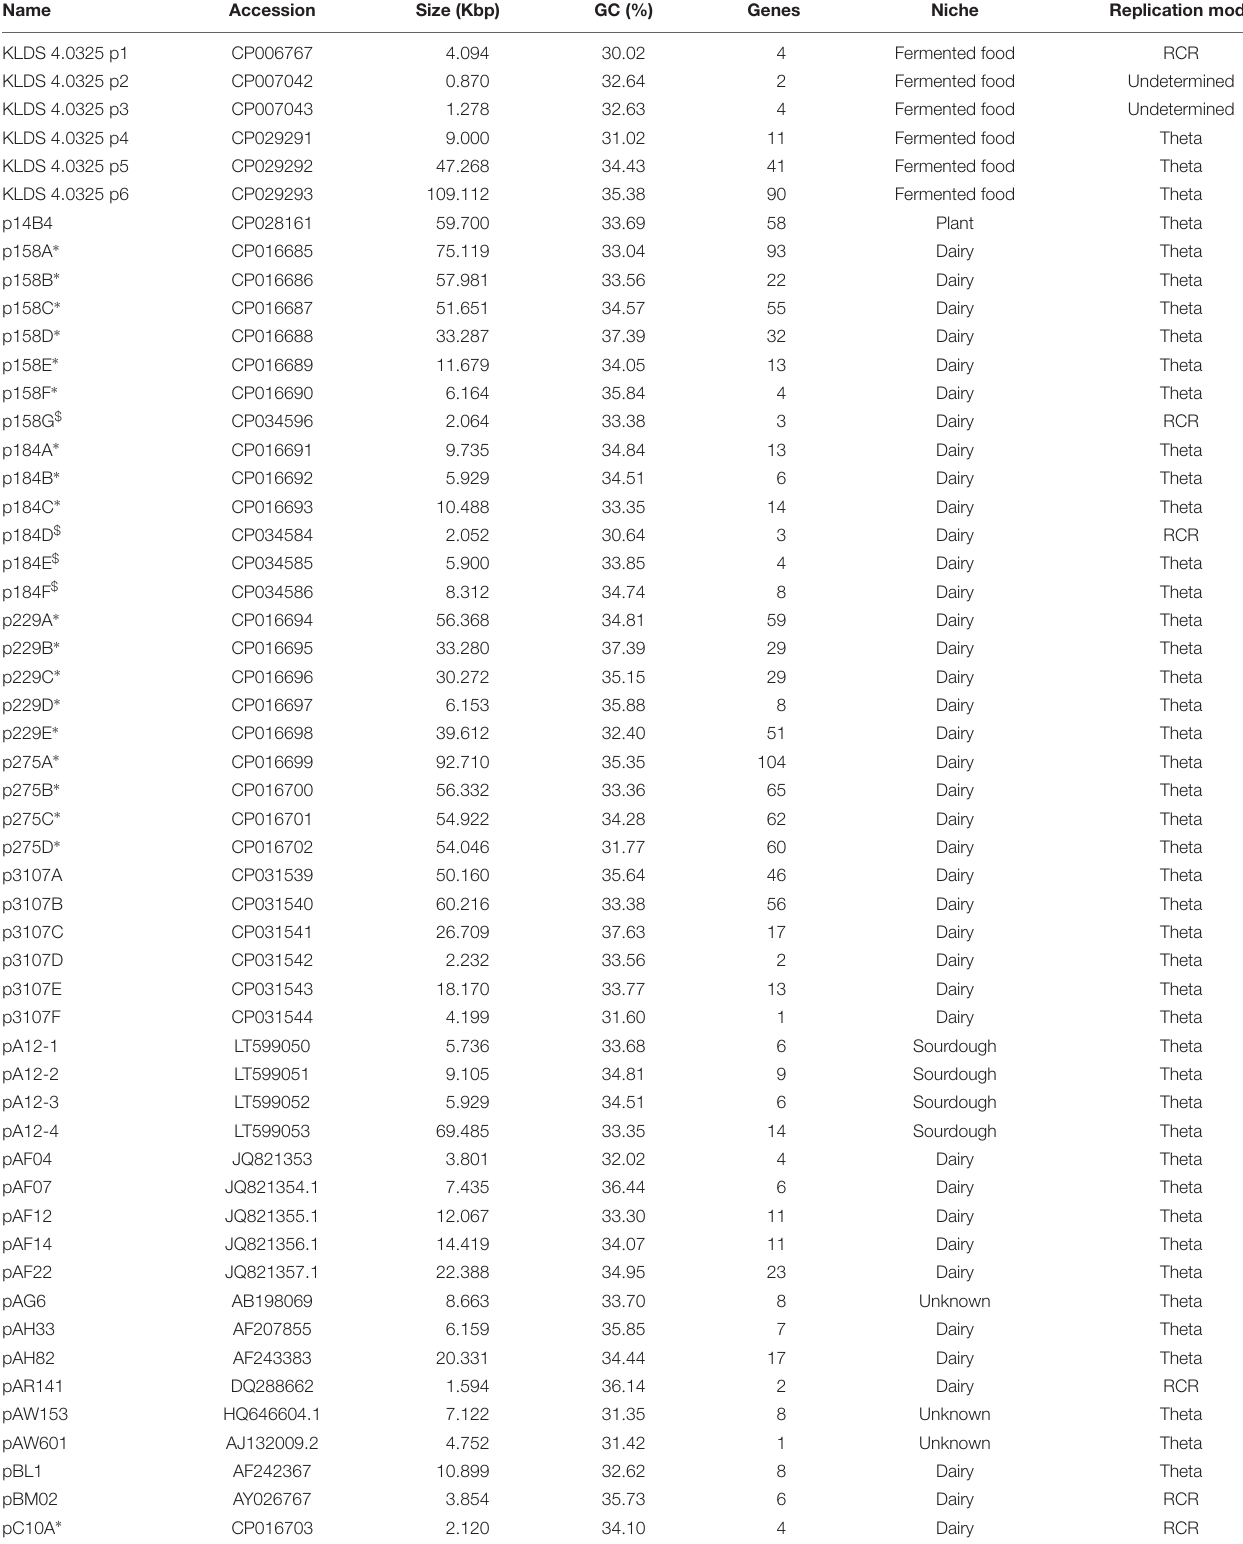
TABLE 1 | Characteristics of the plasmids analyzed in this